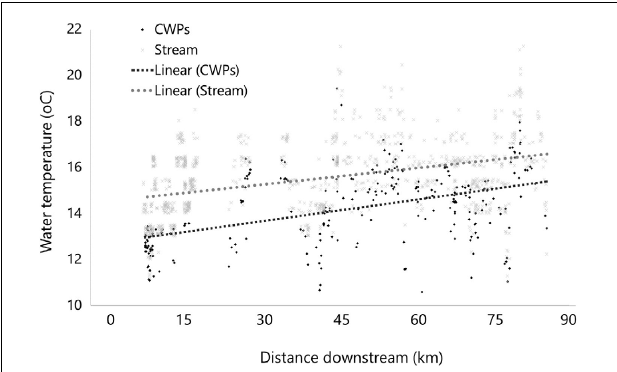
FIGURE 4 | Longitudinal changes in mean stream water temperatures and minimum CWPs temperatures. Note the clusters of no data in the graph reflect the urban areas of Bright and Porepunkah, where no data could be collected, due to flight safety